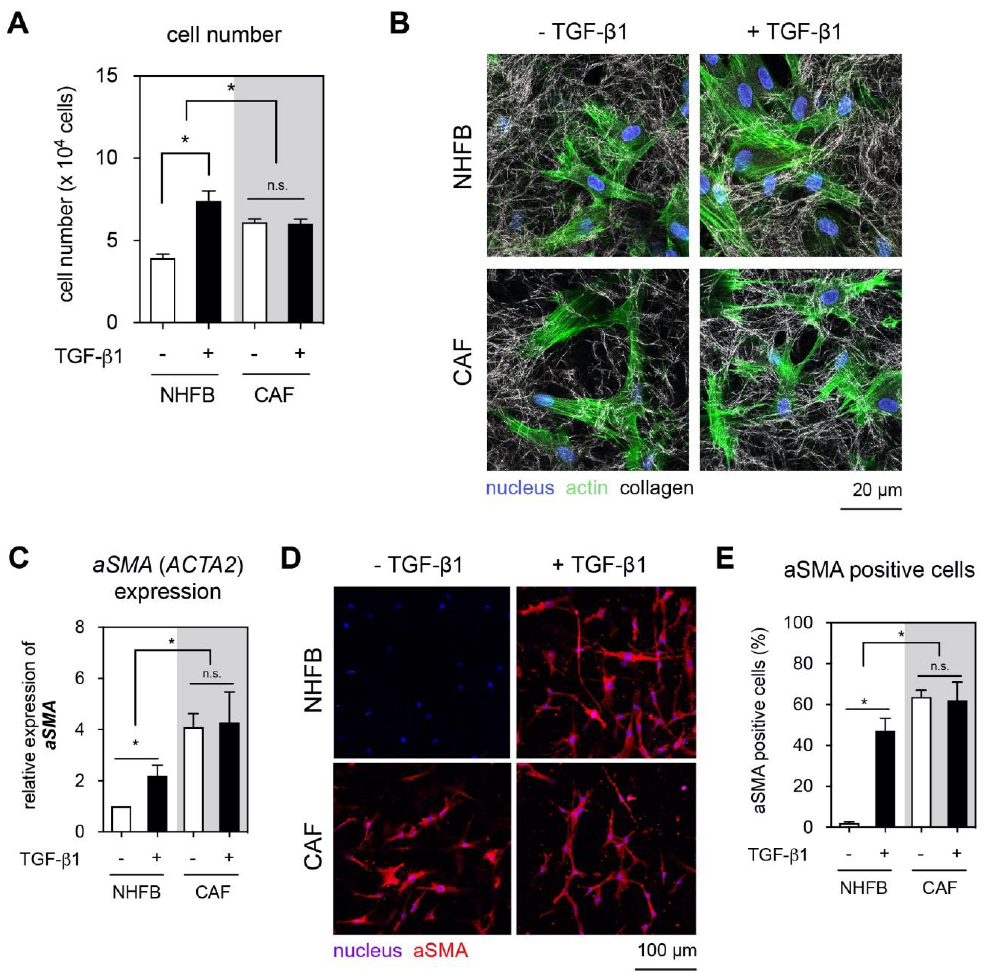
Figure 1. E ff ect of TGF- β 1 on proliferation, aSMA expression, and matrix remodeling of NHFB and CAF. NHFB and CAF were cultured on 3D collagen matrices in the presence and absence of TGF- β 1 for 7 days. Both cells were then characterized in terms of proliferation, aSMA expression, and matrix remodeling. ( A ) Quantitative analysis of cell number using commercial WST-1 assay. ( B ) Representative confocal images of NHFB and CAF. Cells were stained with DAPI and Phalloidin conjugated with Alexa Fluor 488 to visualize nucleus and actin, respectively. Collagen fibrils were imaged in the reflection mode. ( C ) The expression of aSMA was analyzed using qPCR and was normalized to NHFB cultured in the absence of TGF- β 1. ( D ) Immunocytostaining of aSMA and ( E ) quantitative analysis of number of aSMA positive cells by manual count. Data are represented as mean ± SD; *—significance level of p < 0.05; n.s.—not significant. All quantitative experiments were performed at least in 3 replicates with fibroblasts and CAF from 3 different donors for each condition.